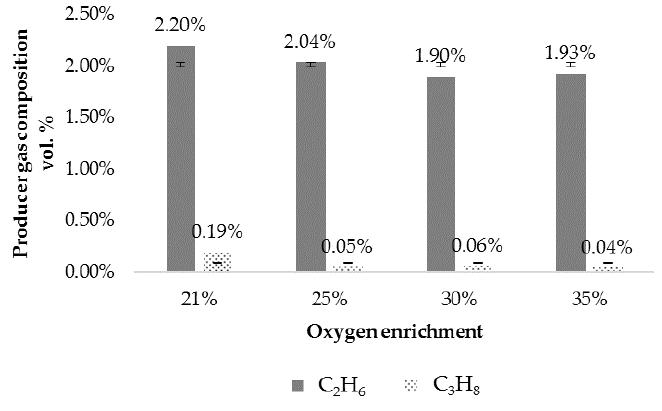
Figure 6. C 2 H 6 and C 3 H 8 compositions in the producer gas.